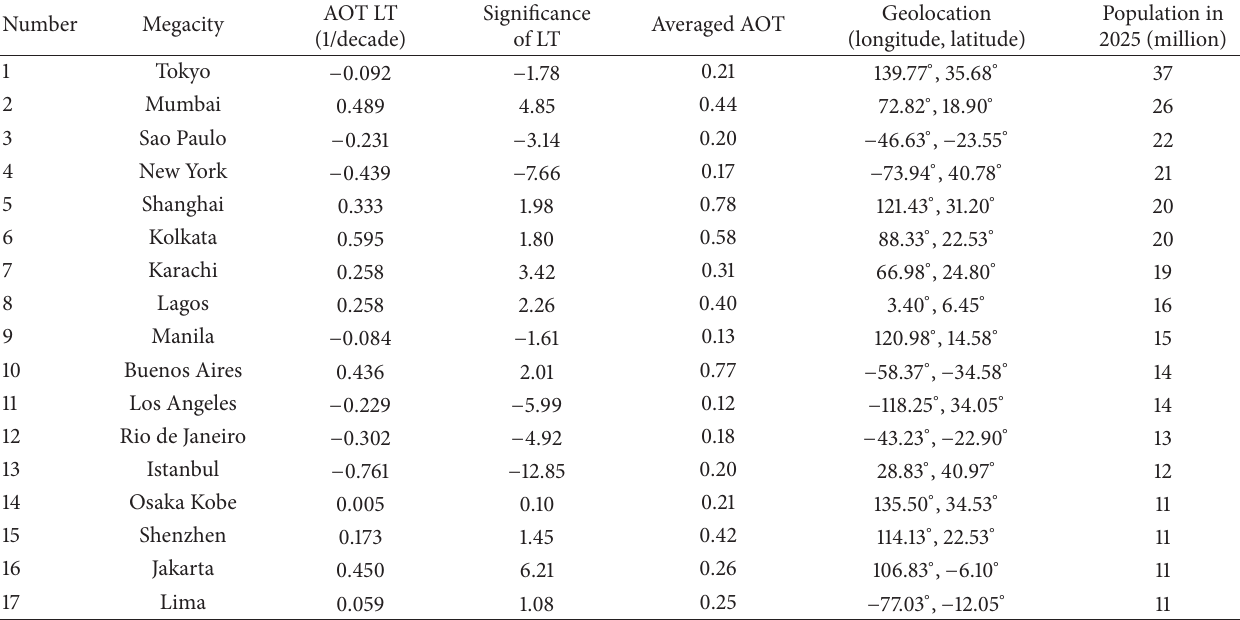
Table 1: AOT linear trend (LT) and its significance (LT/ 𝜎 ) and temporal averaged (1981–2009) monthly mean AOT values for the seventeen MCCZ along with their geolocation and projected population in